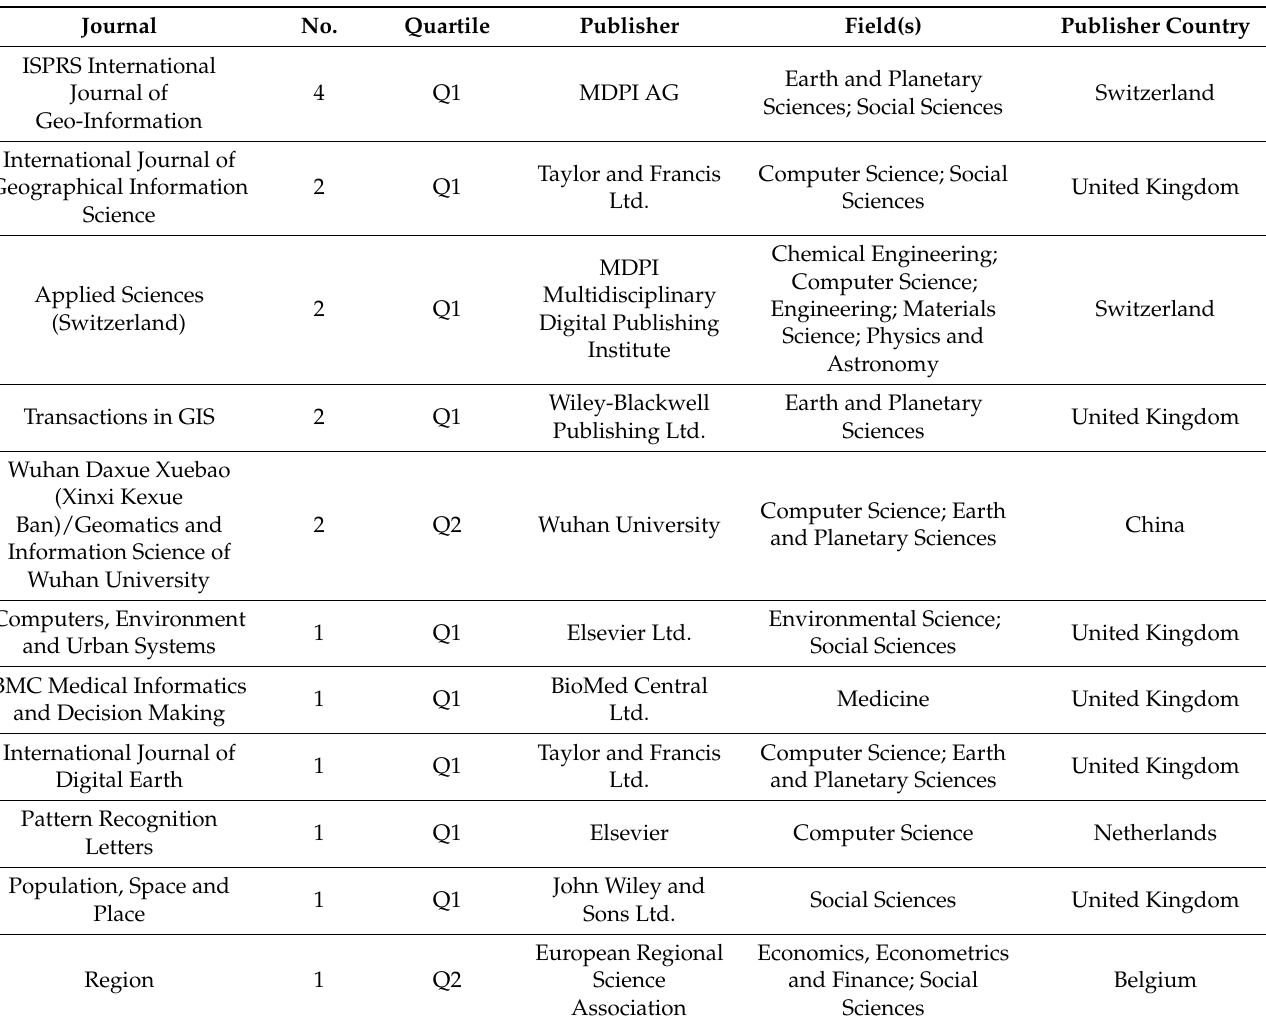
Figure 2. Type and ranking of the selected papers, according to SCImago Journal Rank indicator and http://www.conferenceranks.com (accessed on 9 November 2021). In Tables 1 and 2 the main journals and conference proceedings are presented, respectively. Table 1. Publication sources of the selected journal articles.